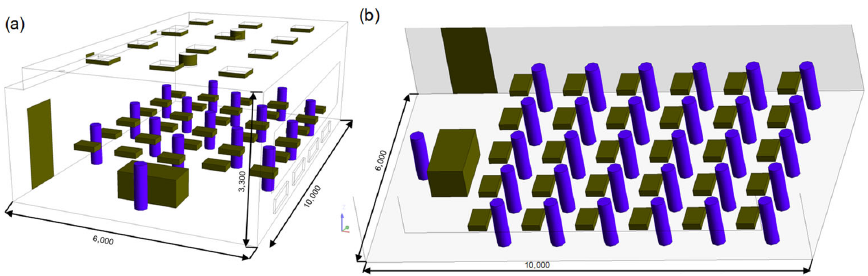
Figure 4. Set-up of the whole classroom by CFD simulation in ( a ) winter case (16 people) and ( b ) summer case (31 people).